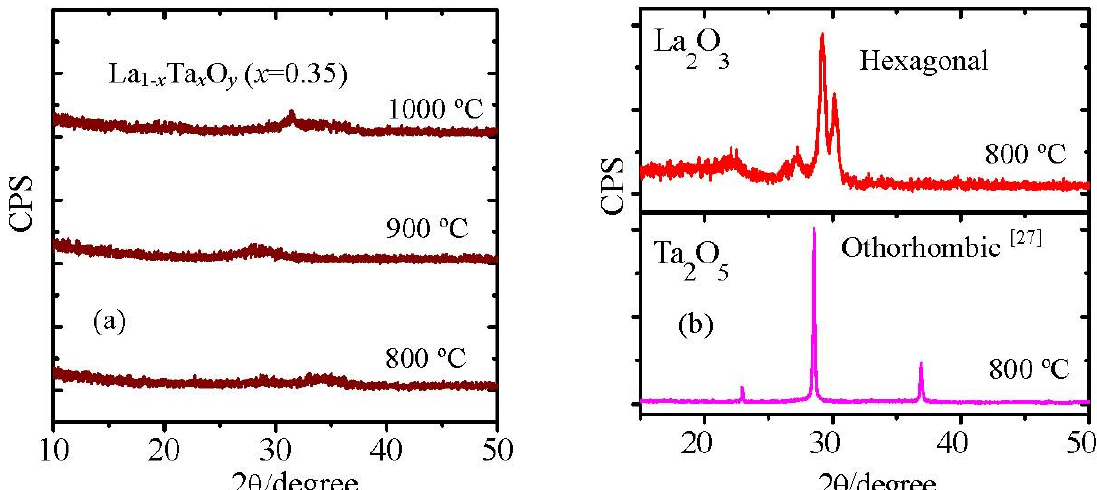
Table 1. Crystallization temperatures of La Ternary Oxide (La